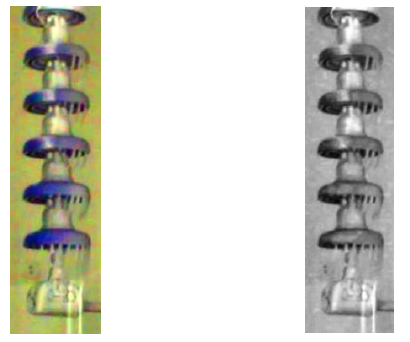
Figure 2. Color image and grayscale image.